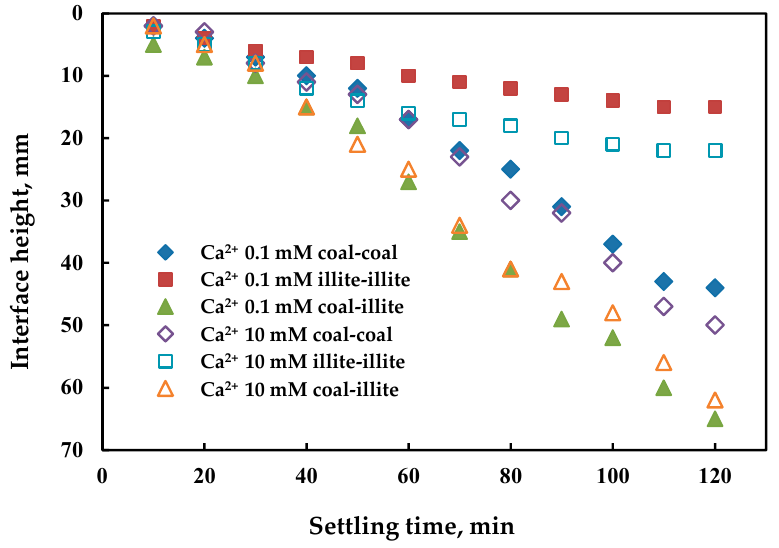
Figure 2. The sedimentation rate of particles with different calcium ion concentrations, where the interface height is the distance from the free surface to the interface between the supernatant and the suspension.